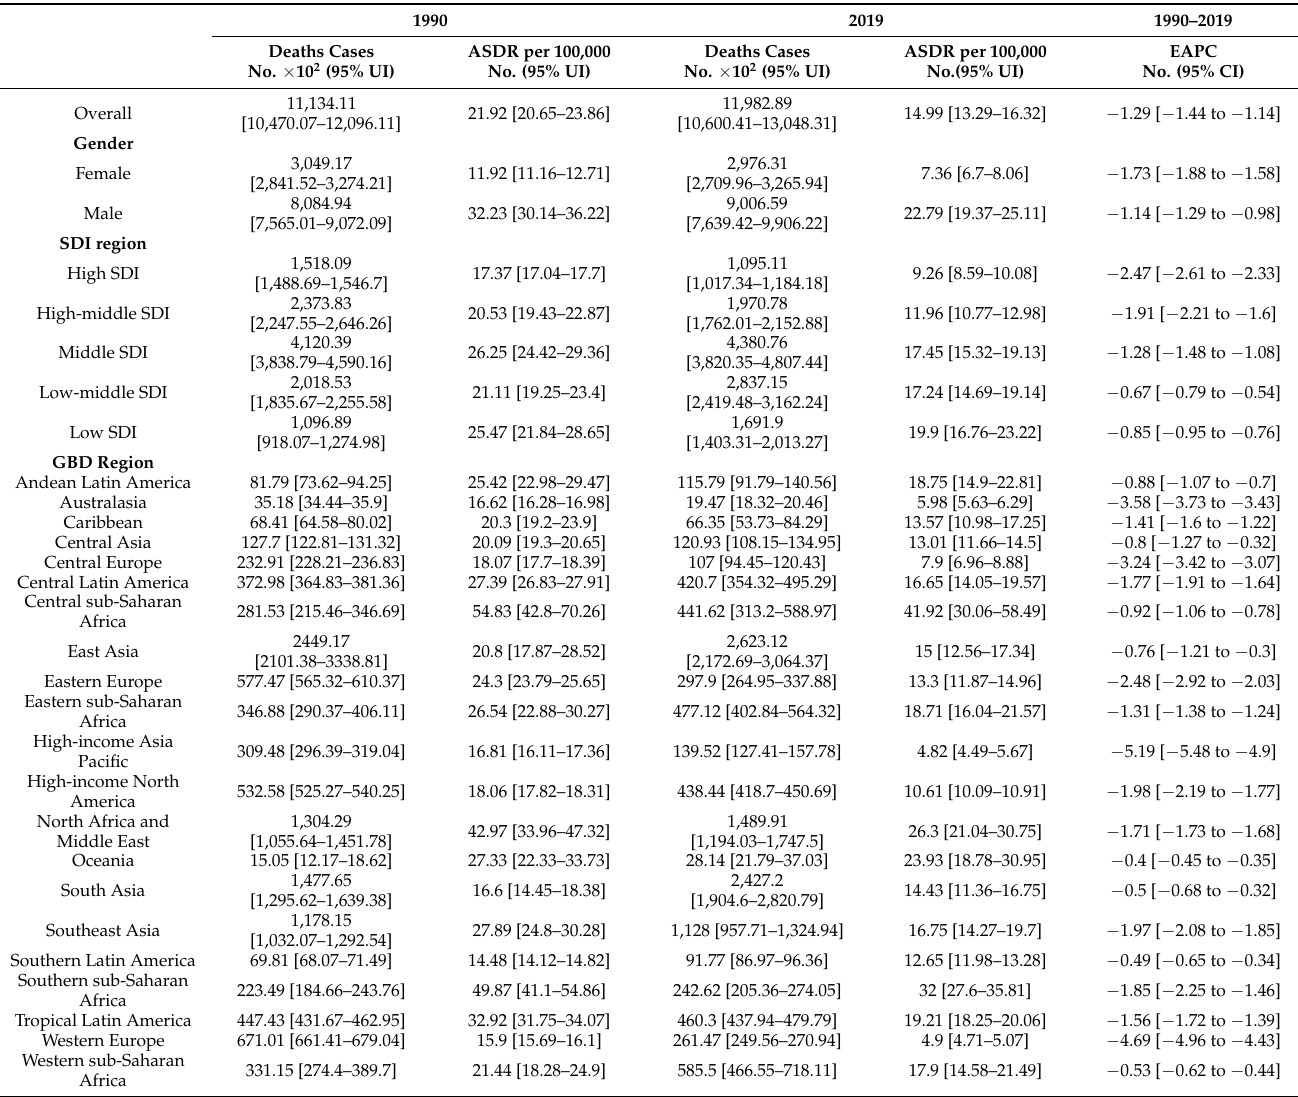
Table 2. Deaths, ASDR, and temporal trends for RI in 1990 and